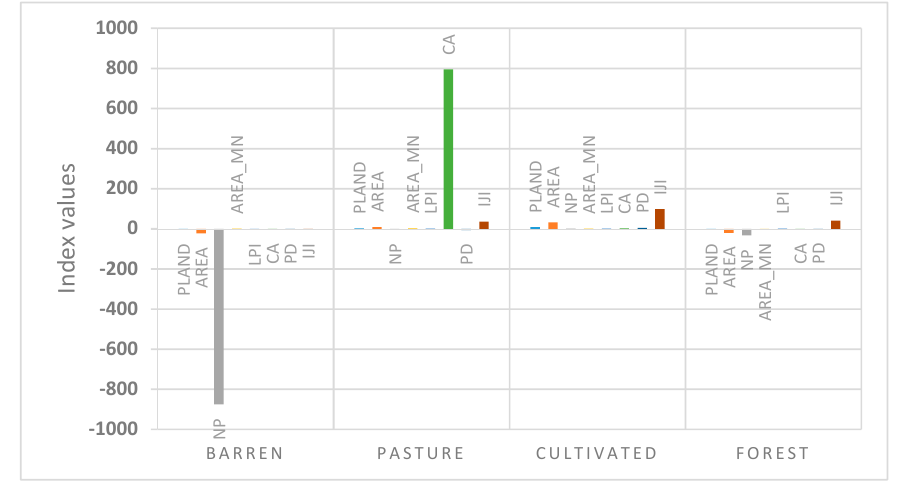
Figure 8. Changes in land use/land cover from 1984 to 1998 for metrics PLAND, AREA, NP, AREA_MN, Largest Patch Index (LPI), class area (CA), Patch Density (PD), and interspersion and juxtaposition (IJI).